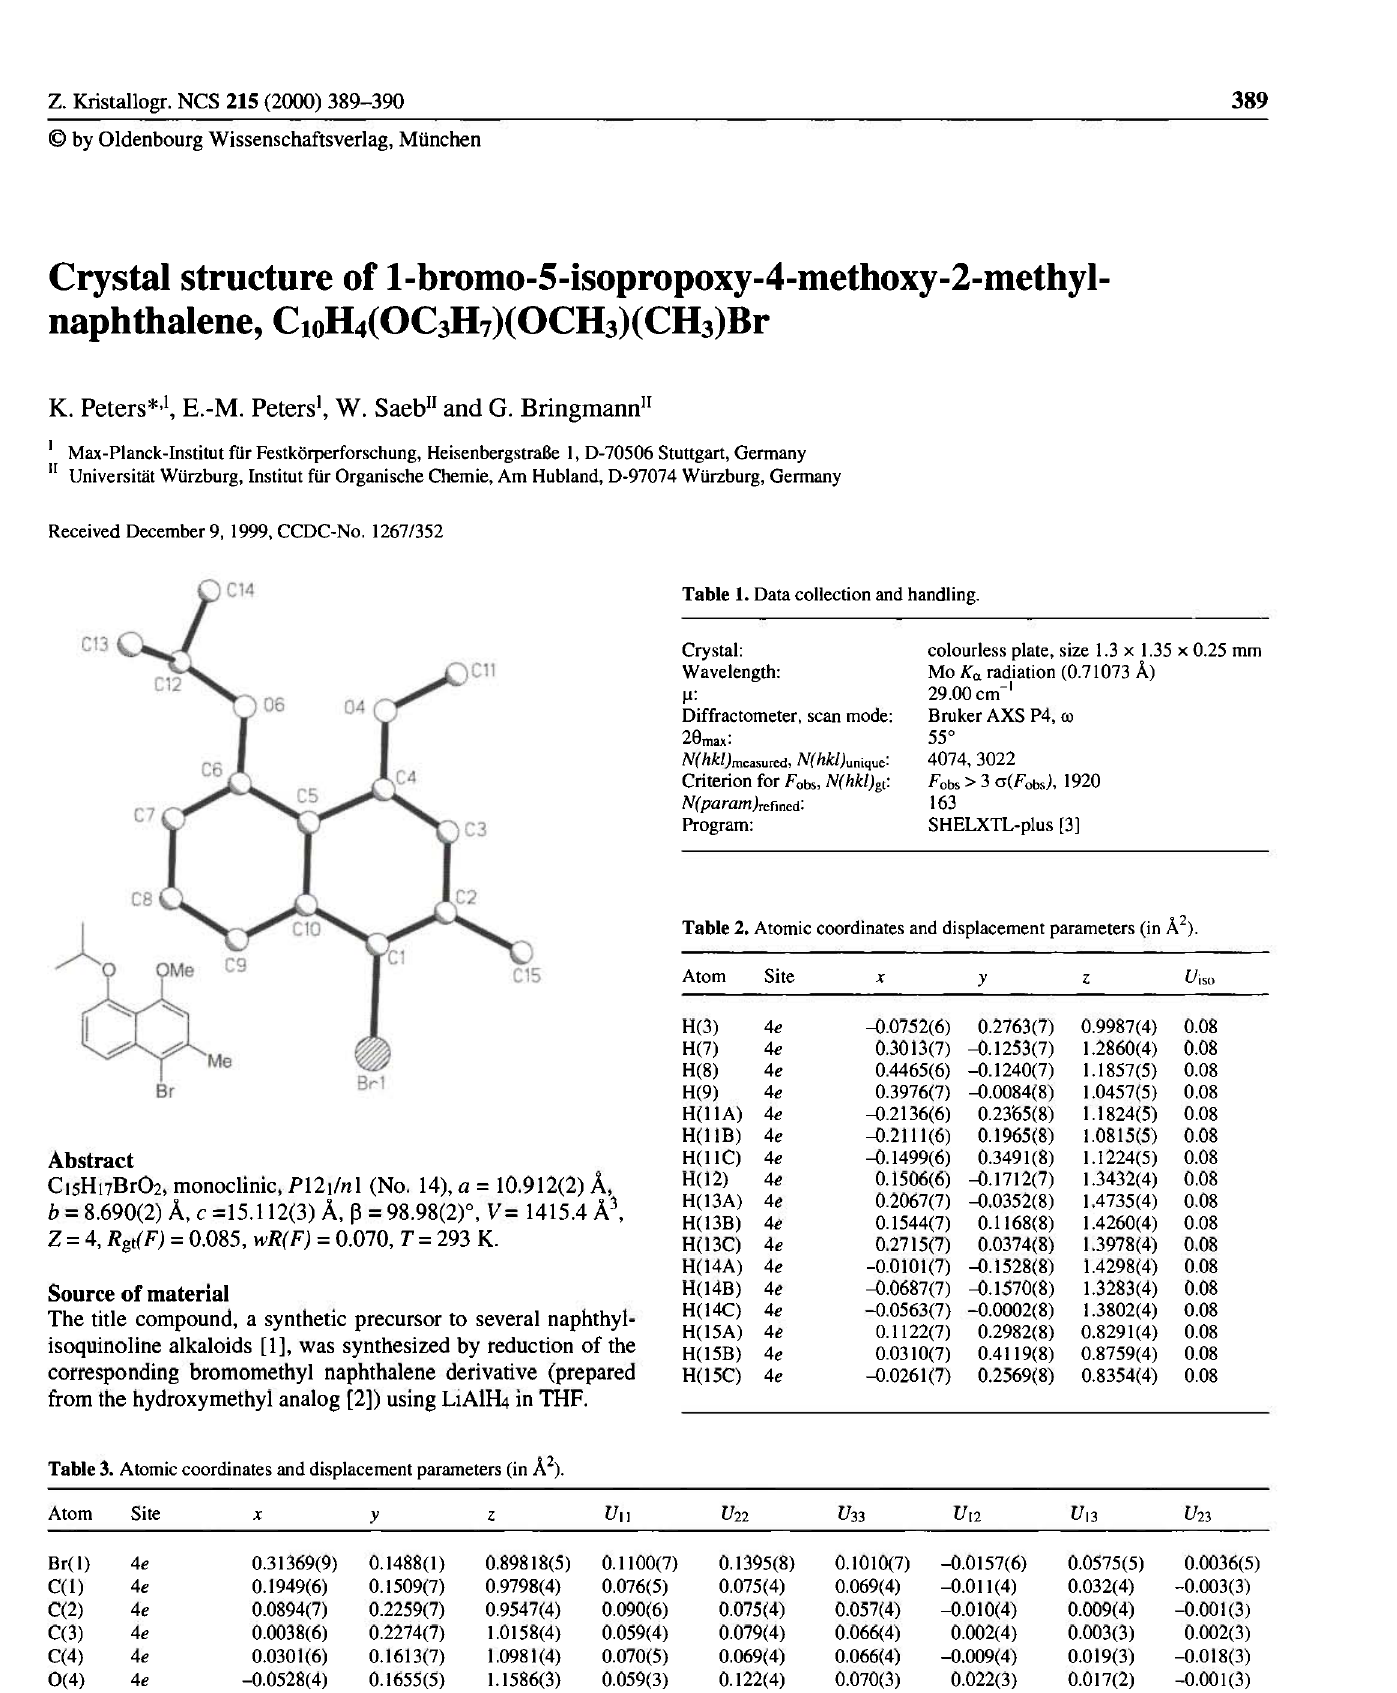
Table 3. Atomic coordinates and displacement parameters (in Ä 2